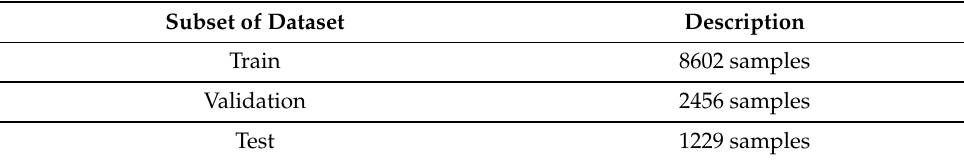
Table 9. Description of each subset of dataset used for detection of the human caruncle area in thermographic context.